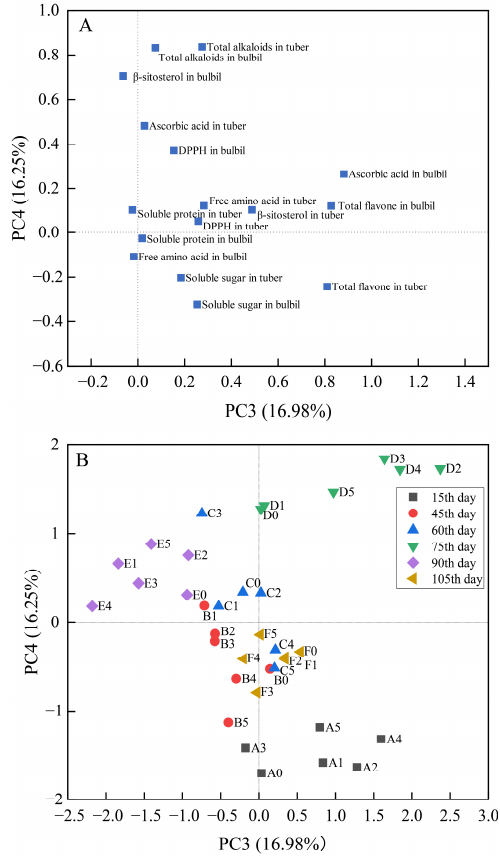
Figure 3. Principal component analysis (PCA) loading ( A ) and scores ( B ) showing correlation of yield and quality parameters in tubers and bulbils of P. ternata with PC3 ‐ PC4 at different stages after BR treatments. A, 15th day; B, 45th day; C, 60th day; D, 75th day; E, 90th day; F, 105th day. 0, 0.00 mg/L BR; 1, 0.05 mg/L BR; 2, 0.10 mg/L BR; 3, 0.50 mg/L BR; 4, 1.00 mg/L BR; 5, 2.00 mg/L BR. PCA was performed on the correlation matrix of values of yield and quality in the tubers and bulbils of P. ternata . 2.3. PC1 ‐ PC2 Loading and Scores for Different Stage after BR